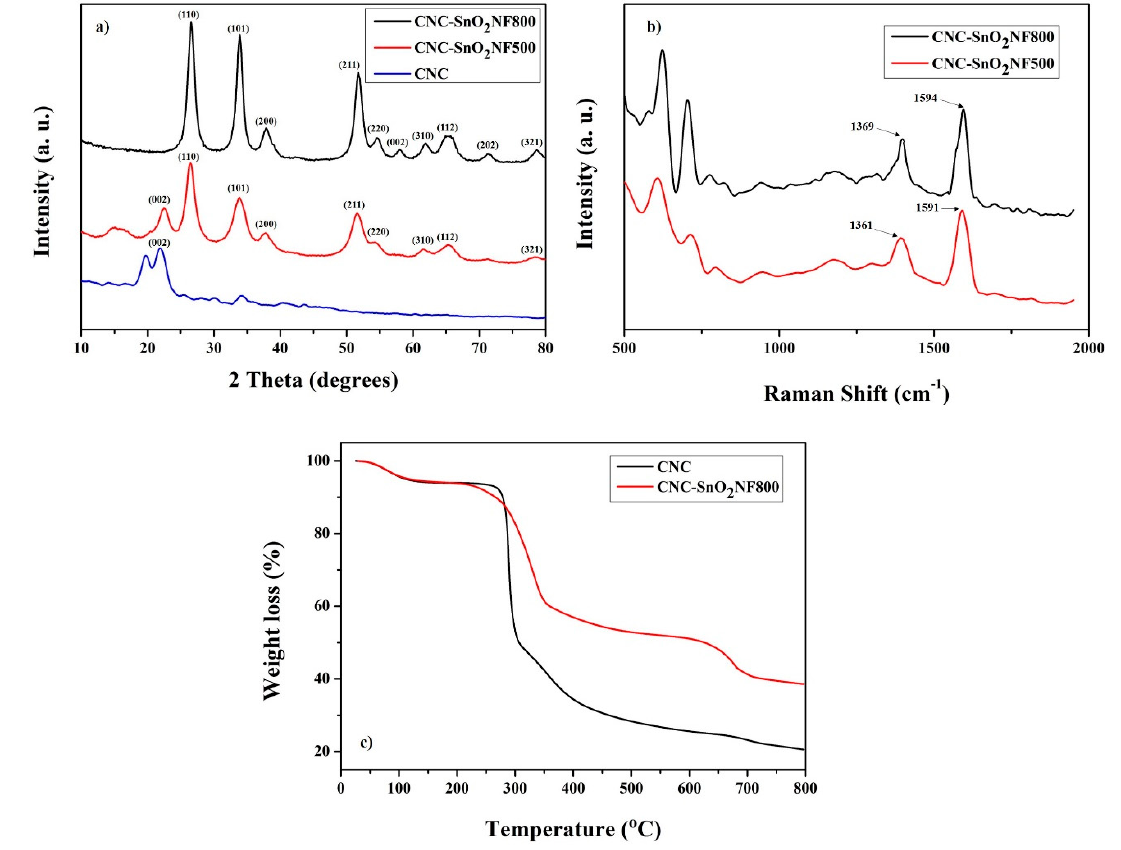
Figure 1. ( a ) XRD patterns of nanocrystalline cellulose (CNC) and the CNC–tin dioxide (SnO 2